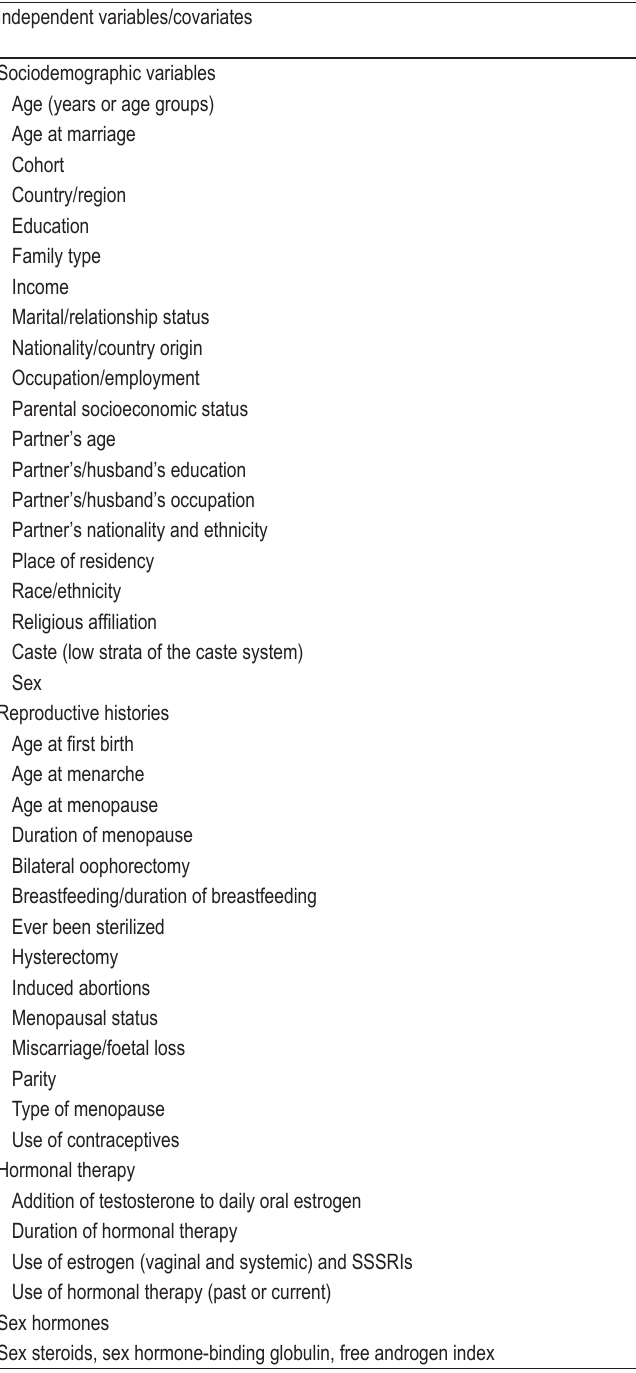
TABLE 7. Independent variables and/or covariates in 22 eligible